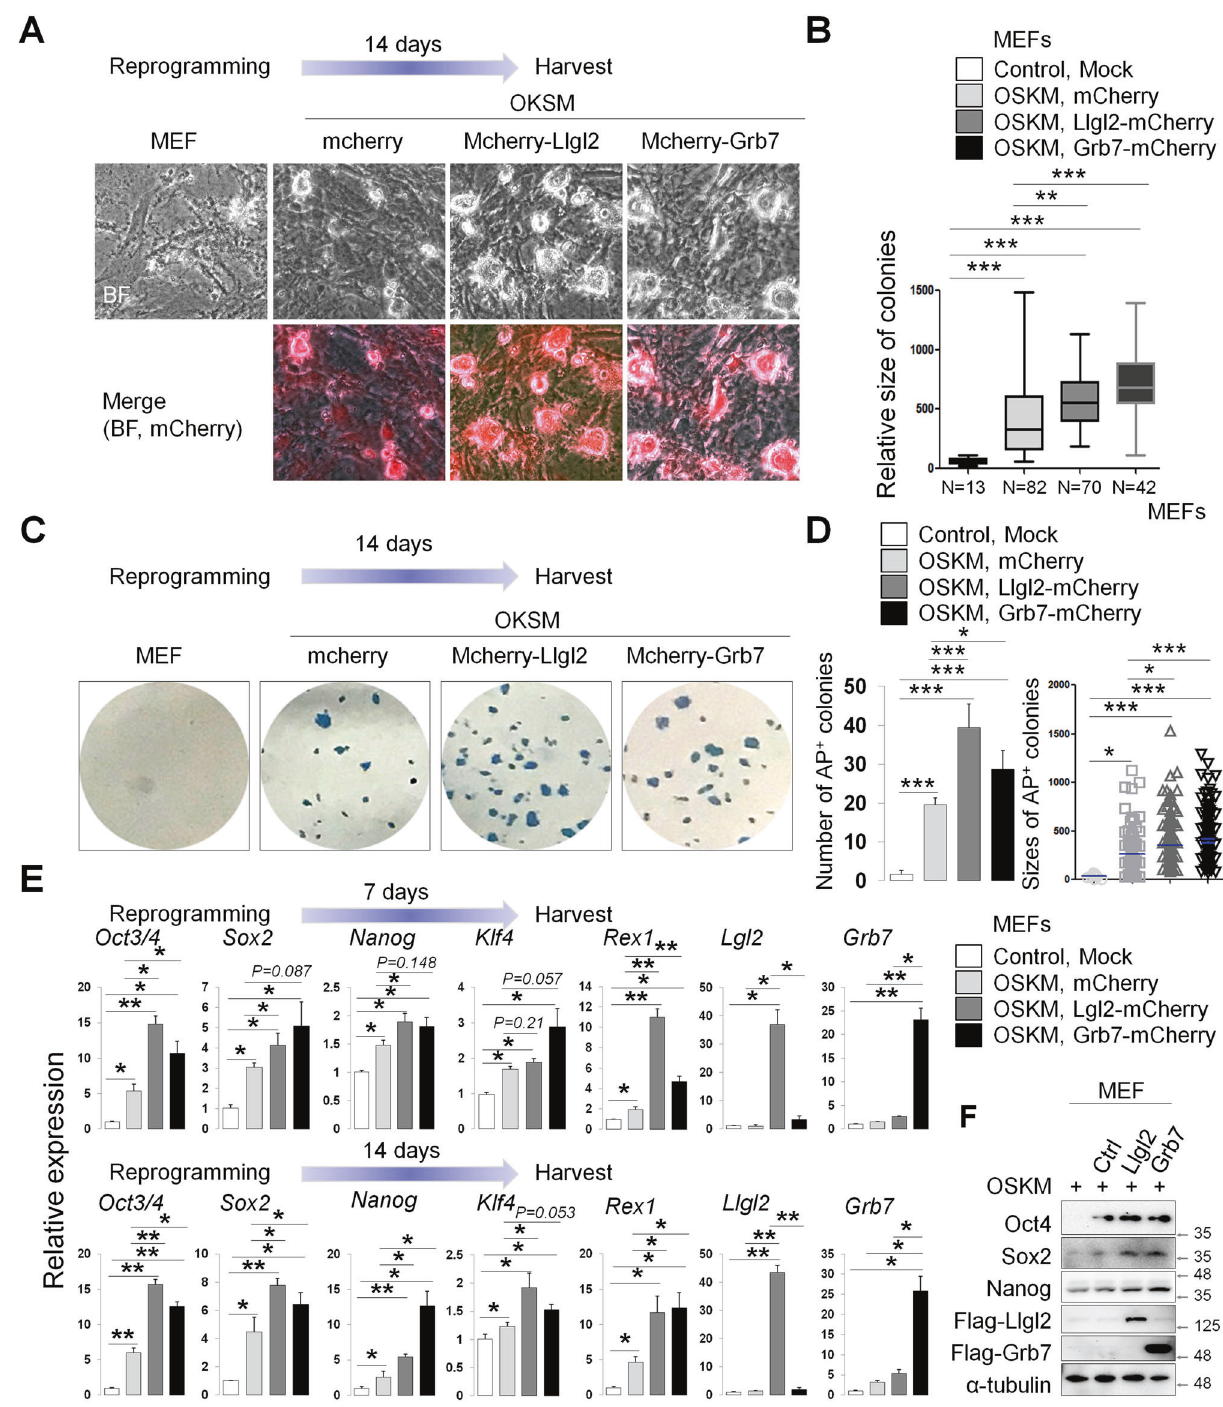
Fig. 5 Overexpression of Llgl2 and Grb7 enhances reprogramming ef fi ciency. A Time course for reprogramming of early passage MEFs with retroviral supernatants containing pMX-hOct4, hSox2, hKlf4, hc-Myc, and either pMX-T2A-mCherry, mLlgl2-T2A-mCherry, or mGrb7-T2A- mCherry. Representative colonies imaged at 14 days post transduction. Images taken at 40X scale; B Quanti fi cation of reprogramming colony sizes by day 14 post transduction; C Alkaline phosphatase staining of colonies on day 14 post transduction. Representative wells shown; D Quanti fi cation of AP + colony numbers and size on day 14 post transduction; E Quantitative PCR analysis of pluripotency gene expression for reprogramming wells at day 7 and day 14 post transduction; F Immunoblotting for pluripotency factors OCT4, SOX2, and NANOG in reprogrammed colonies from MEFs. LLGL2 and GRB7 overexpression con fi rmed with anti-FLAG antibody. Normalized to α -Tubulin levels. In panels B , D , E , data plotted are mean ± SD for triplicate samples and were compared by one-way ANOVA with Tukey ’ s post hoc test. (* p < 0.01, ** p < 0.001, *** p < 0.0001).